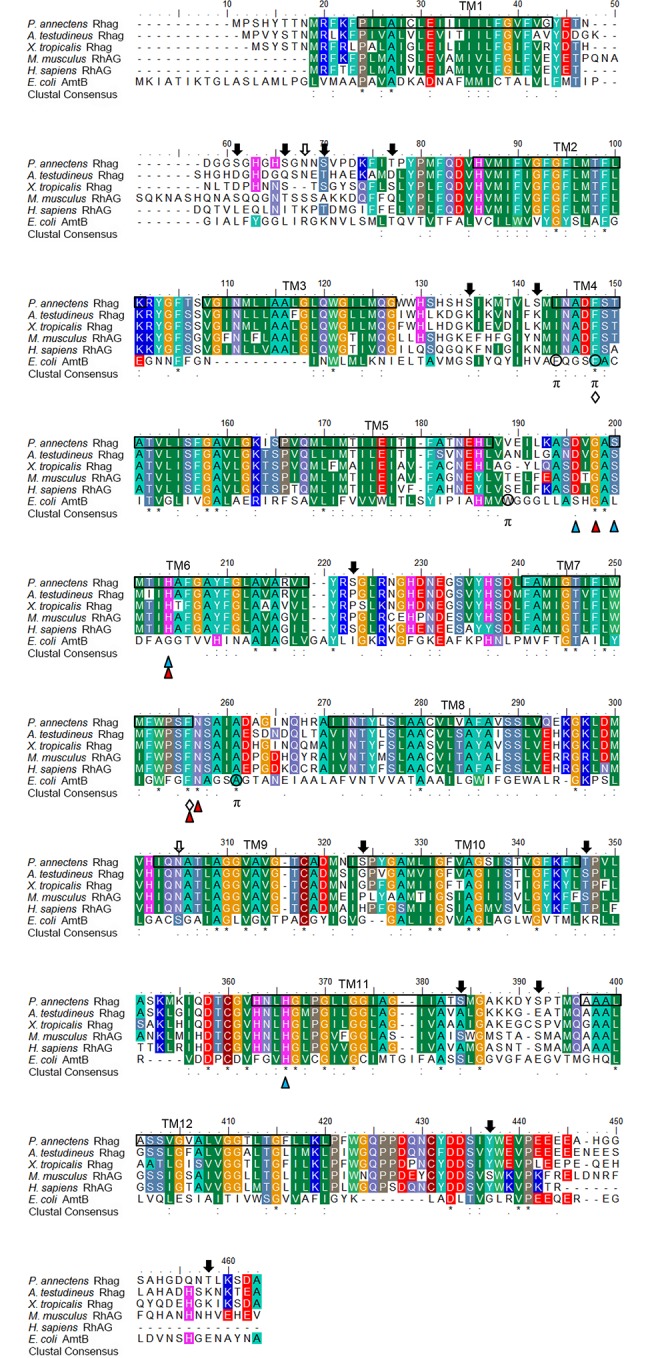
Molecular characterization of Rhesus blood group-associated glycoprotein (Rhag) from the gills of Protopterus annectens.A multiple amino acid alignment of Rhag from Protopterus annectens with Anabas testudineus Rhag (AIC81181.1), Xenopus (Silurana) tropicalis Rhag (XP_002933645.2), Mus musculus RhAG (AAI01942.1), Homo sapiens RhAG (NP_000315.2) and Escherichia coli ammonia transporter (AmtB; NP_414985.1). Identical amino acid residues are indicated by asterisks, strongly similar amino acids are indicated by colons and weakly similar amino acids are indicated by periods. Residues involved in NH4+ binding and deprotonation of NH4+ for NH3 conduction are indicated by red and blue triangles, respectively. The phenylalanine gate is indicated by open diamonds. The π cation binding sites of E. coli AmtB are indicated by “π”. Potential N-glycosylation and phosphorylation sites are indicated by open and shaded arrows, respectively. The predicted transmembrane domains (TM1‒12) of Rhag of P. annectens are indicated by open boxes and were predicted using MEMSATS and MEMSAT-SVA provided by PSIPRED protein structure prediction server.